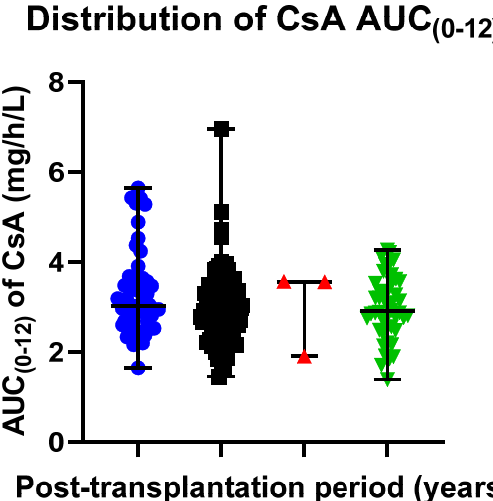
Figure 5. Distribution of the CsA AUC (0–12) exposure values in the study groups: CsA + MMF and CsA monotherapy; MMF—mycophenolate mofetil; CsA—cyclosporine. Scatter plots display the individual AUC (0–12) exposure values’ distribution from the median in CsA-receiving study groups (median ± SE): 3.02 ± 0.13 mg / h / L (CsA + MMF, post-transplantation time: 1–5 years) versus 3.56 ± 0.55 mg / h / L (CsA monotherapy, post-transplantation time: 1–5 years); 2.84 ± 0.80 mg / h / L (CsA + MMF, post-transplantation time > 5 years) versus 2.91 ± 0.10 mg / h / L (CsA monotherapy, post-transplantation time > 5 years). Respectively, the mean values (mean ± SD) were as follows: 3.31 ± 0.94 µ g / h / L (Tacro + MMF, post-transplantation time: 1–5 years) versus 3.01 ± 0.96 µ g / h / L (Tacro monotherapy, post-transplantation time: 1–5 years); 2.96 ± 0.79 µ g / h / L (Tacro + MMF, post-transplantation time > 5 years) versus 2.98 ± 0.70 µ g / h / L (Tacro monotherapy, post-transplantation time > 5